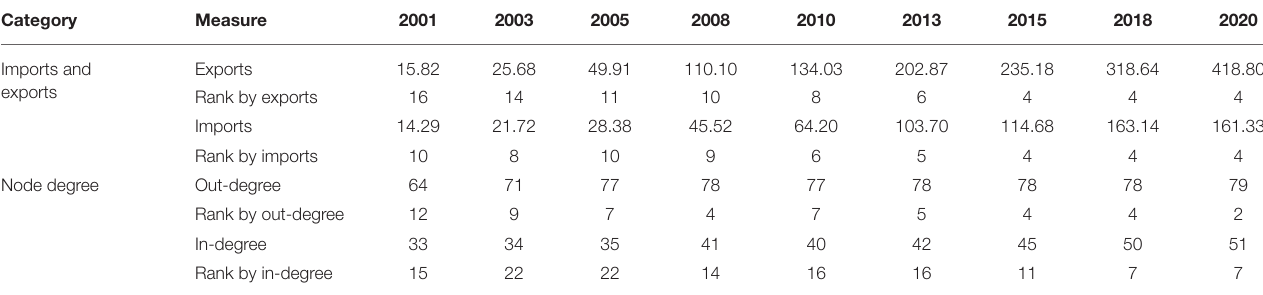
TABLE 4 | China’s node degrees, imports and exports, and rankings in the medical device trade. Category